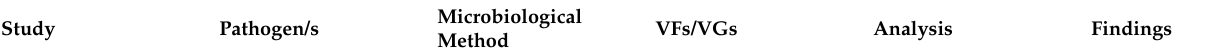
Table 5. VFs distribution among strains causing infection from different portal of